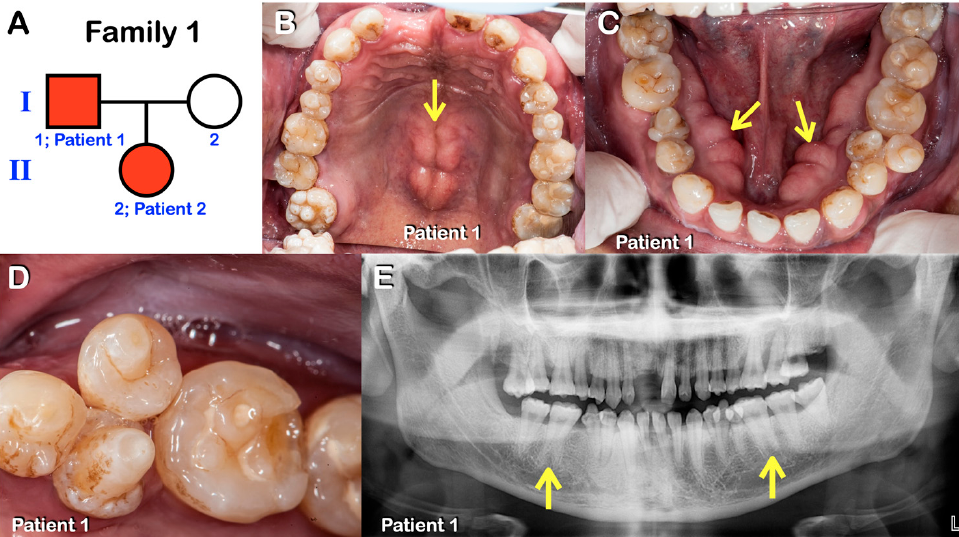
Figure 1. ( A – E ) Family 1. ( A ) Pedigree of family 1. Patients 1 and 2. ( B – D ) Patient 1. Permanent dentition. Round-shaped permanent molars, molars with multiple supernumerary cusps, premolars with single prominent cusps, torus palatinus (arrow in B), and torus mandibularis (arrows in C). Close-up view of mandibular premolars with single prominent cusps. ( E ) Panoramic radiograph showing agenesis of the right permanent mandibular third molar, single-rooted permanent molars, and taurodontism